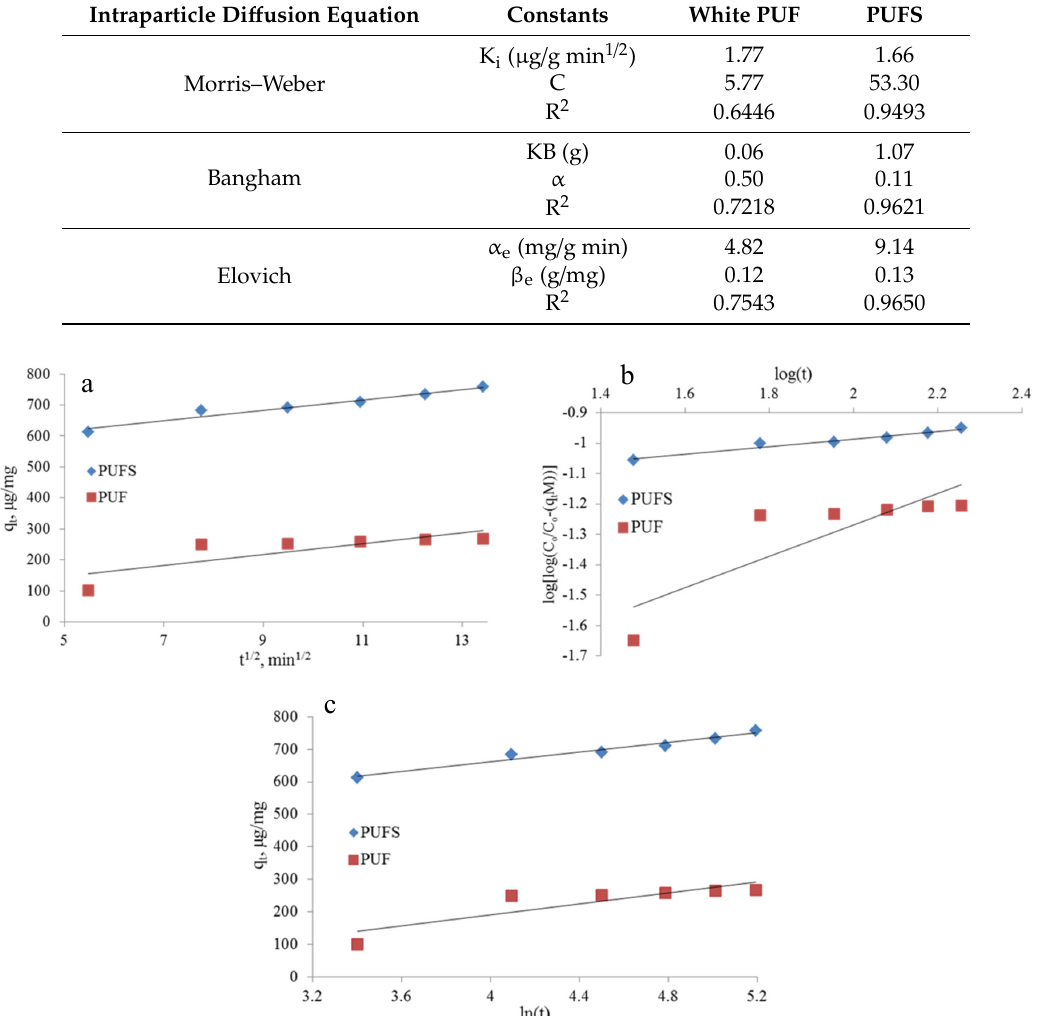
Table 7. Intraparticle Di ff usion Constants for Adsorption of Chlorpyrifos onto White-PUF and PUFS.